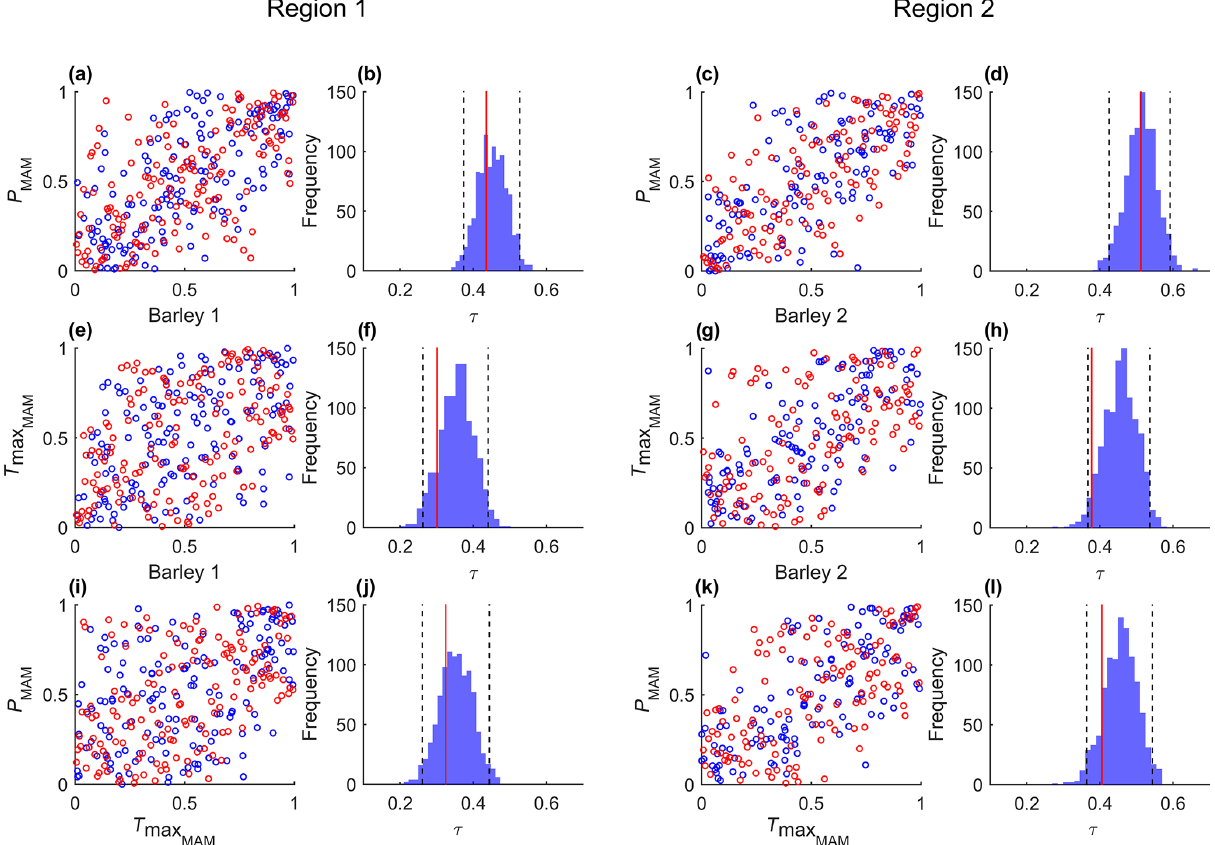
Figure A1. Same as Fig. 5 but for